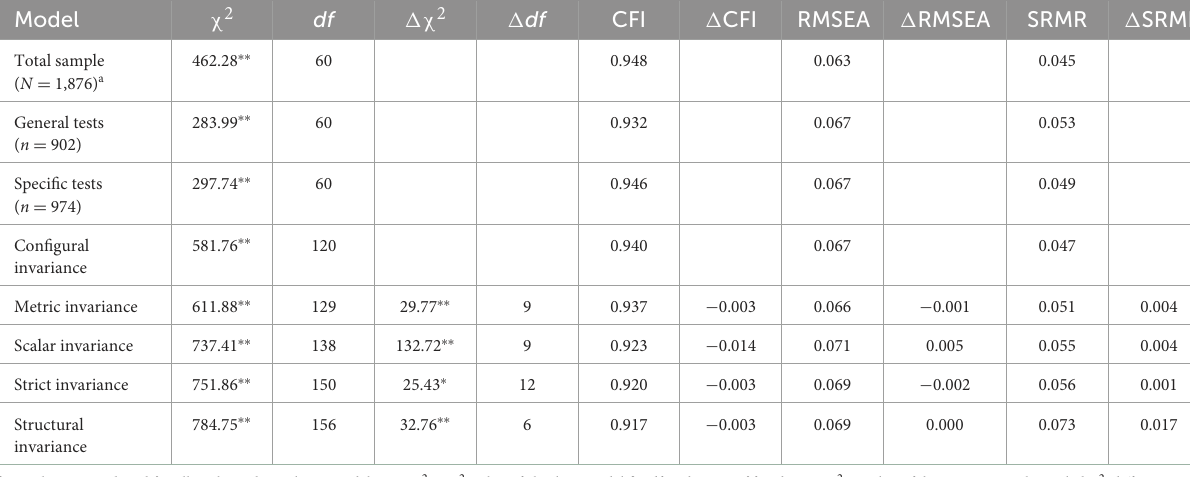
TABLE 3 SEM results for total, individual, and invariance models across general and specific tests.